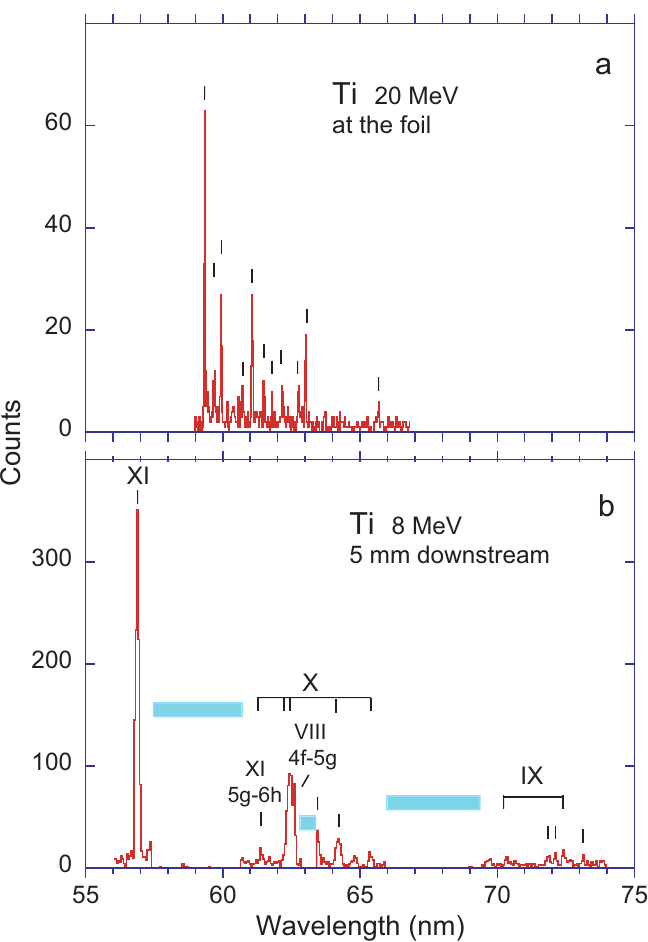
Figure 9. Beam–foil spectra of Ti recorded at ion beam energies of ( a ) 20 MeV and ( b ) 8 MeV. Grating 600 L/mm, line width (FWHM) 0.045 nm in ( a ) and 0.15 nm in ( b ). The strongest lines are identified by the spectrum number. The charge state distributions are close to those of Figure 1b. The light blue horizontal bars mark ranges of data recording with a reduced ion beam charge preset per channel. Spectrum ( a ) has been recorded right after excitation; spectrum ( b ) corresponds to a delay of about 880